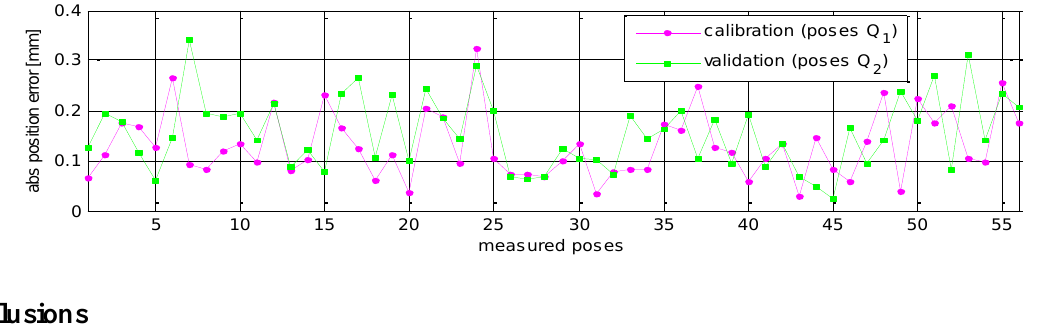
and validation poses Q 1